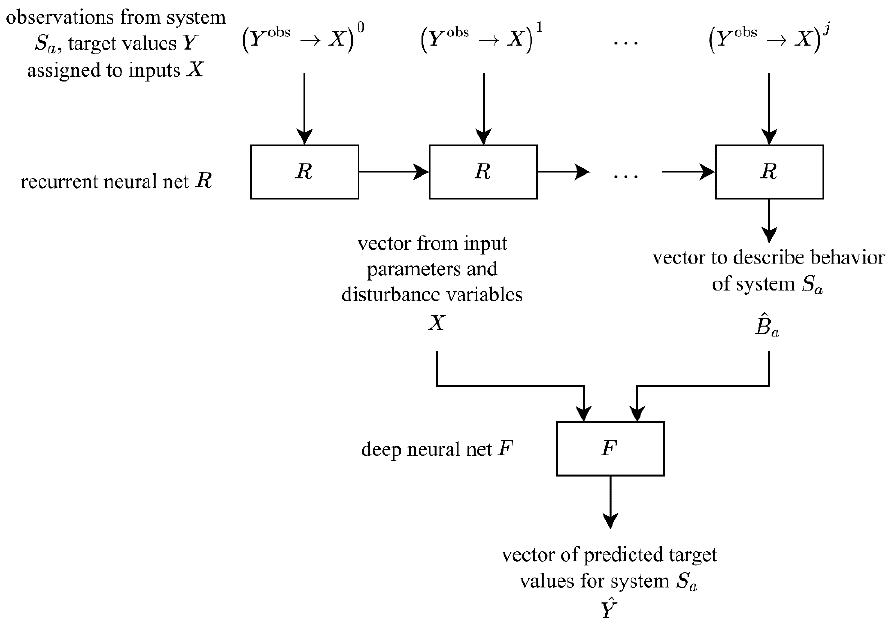
Figure 5. Predictions are made using observations 𝑌 obs and a vector X of inputs.